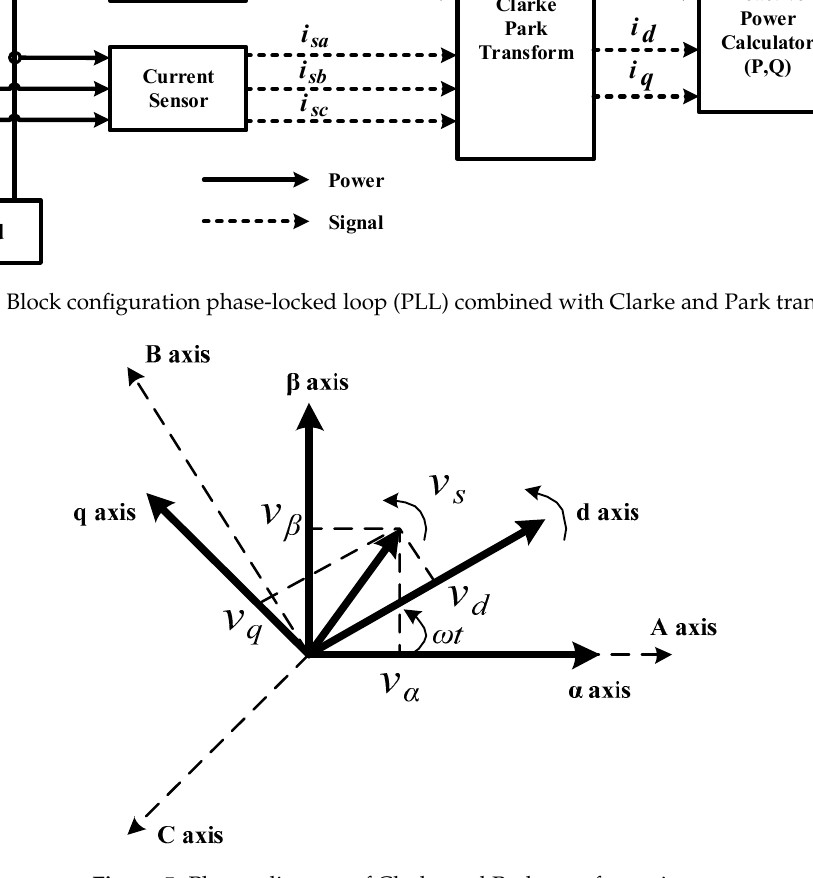
Figure 5. Phasor diagram of Clarke and Park transformation.